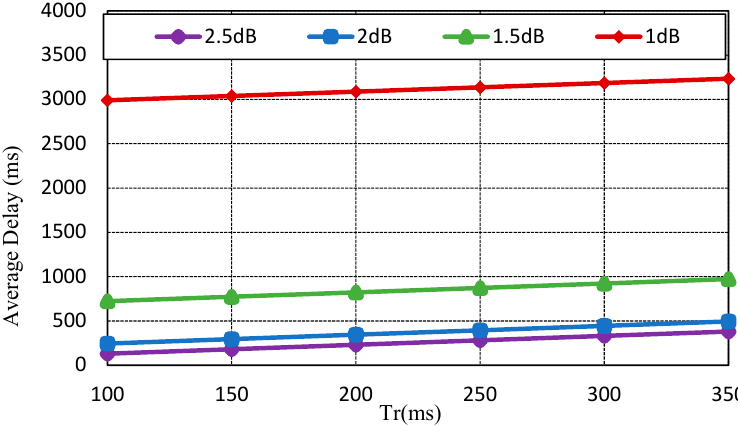
Figure 4. Average delay of signal-to-noise ratios (SNRs) by impact of roundtrip time T r .